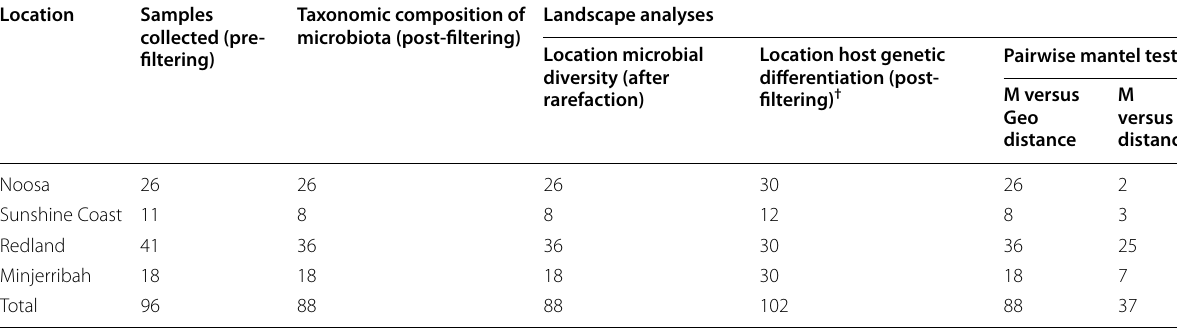
M microbial, Geo = † Additional koala DNA samples used for robust population genetic (F